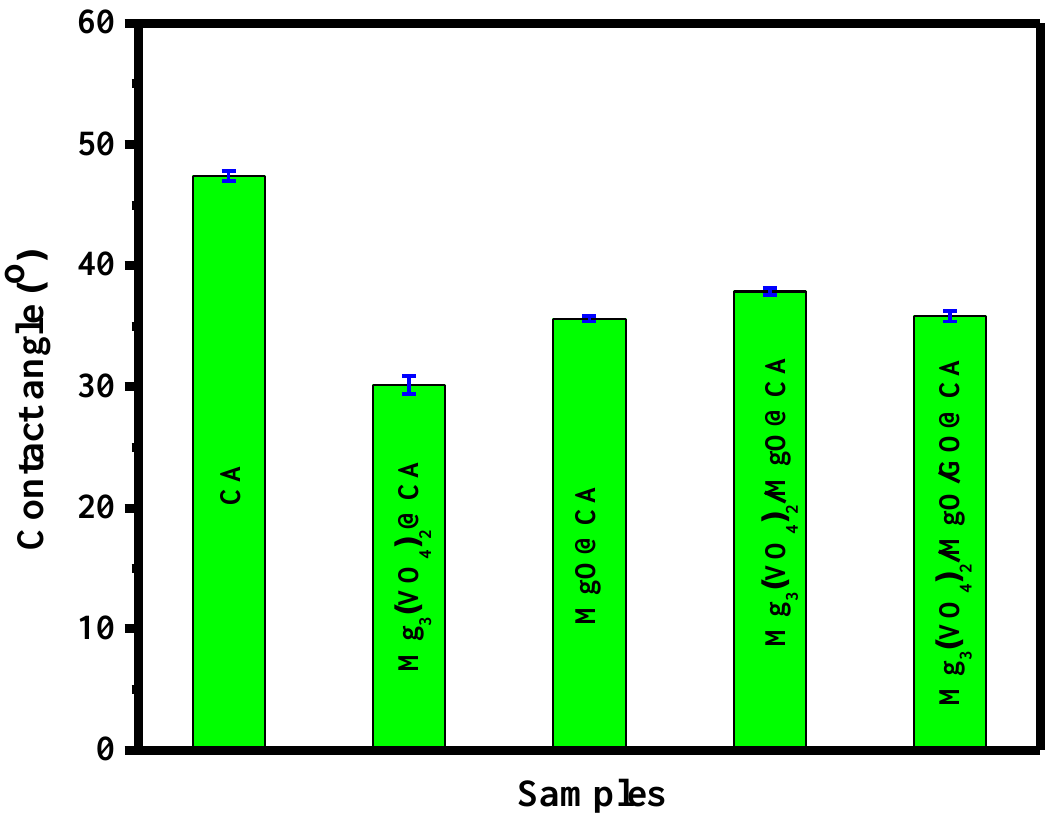
Figure 5. Contact angle histogram for CA and modified films.